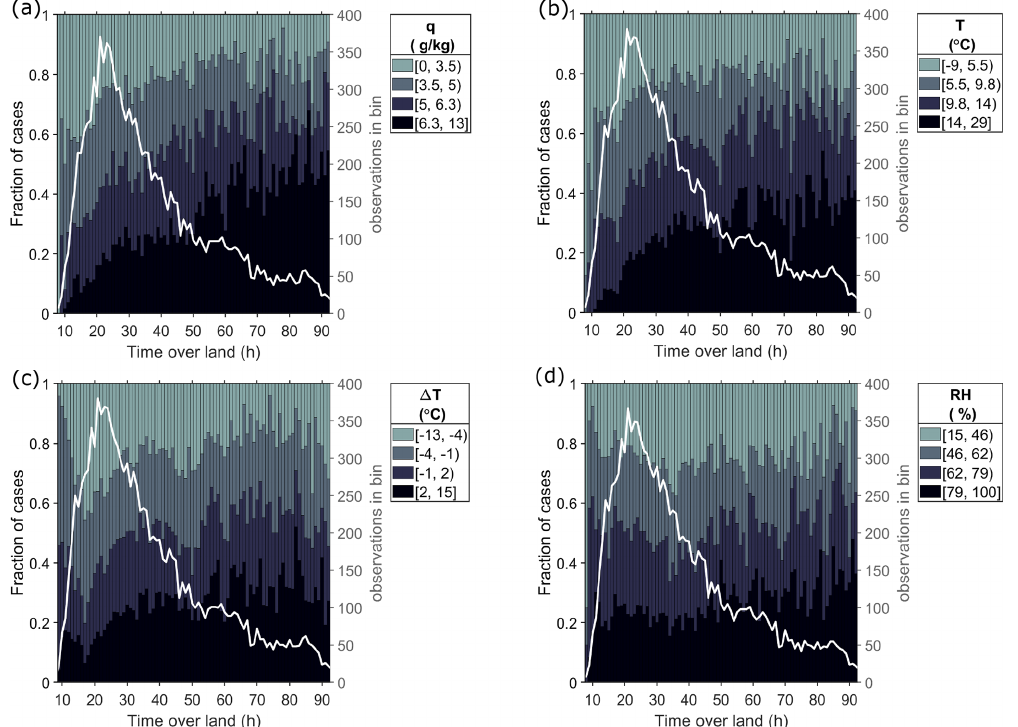
Figure 6. Fractions of observed (a) specific humidity ( q ), (b) temperature, (c) temperature deviation from monthly median, and (d) relative humidity, in four different value ranges, as a function of ToL. The white lines and the right y axes show the number of observations in each bin. The general description of this figure is the same as for Fig. 3, except that here the ToLs are binned into hourly bins, which was possible with the higher data availability. The same ToL cut-off limit of 92.5h is still maintained for consistency.